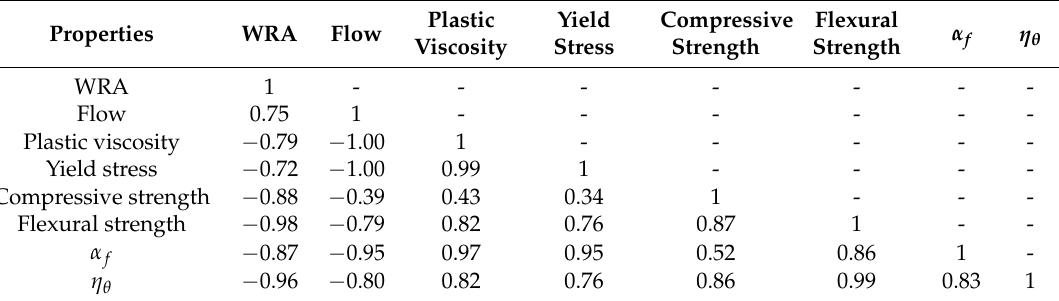
Table 3. Correlation of properties of